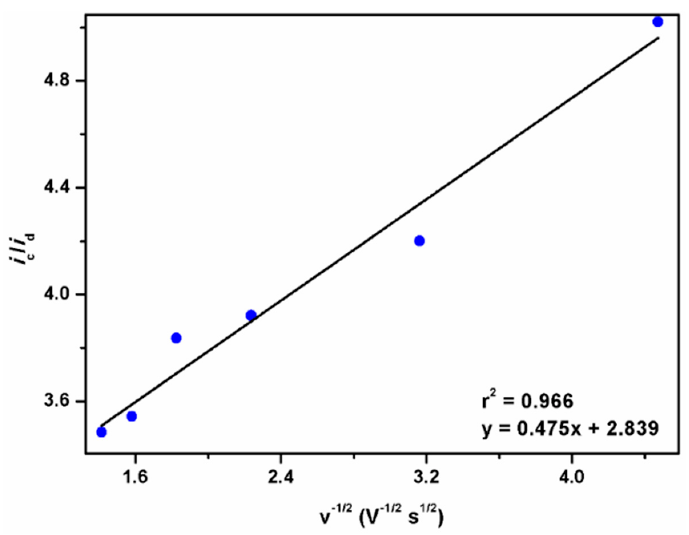
Figure 13. A plot of i c / i d vs. v − 1/2 for a solution containing 1.0 mM Na 3 [Ru 2 ( µ- CO 3 ) 4 ] in 0.10 M NaHCO 3 (pH—8.3). The i c is taken at 1.56 V.